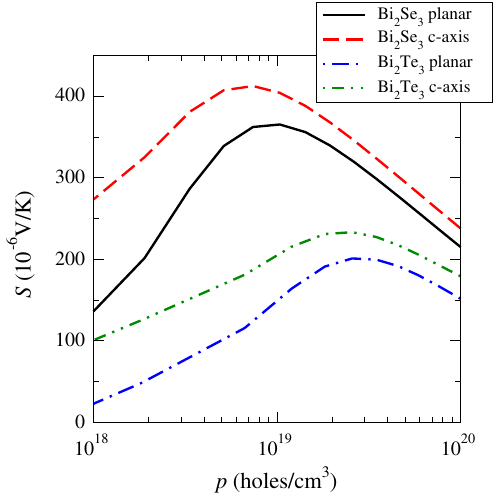
FIG. 4. The calculated thermopower for Bi 2 Se 3 and Bi 2 Te 3 at 500